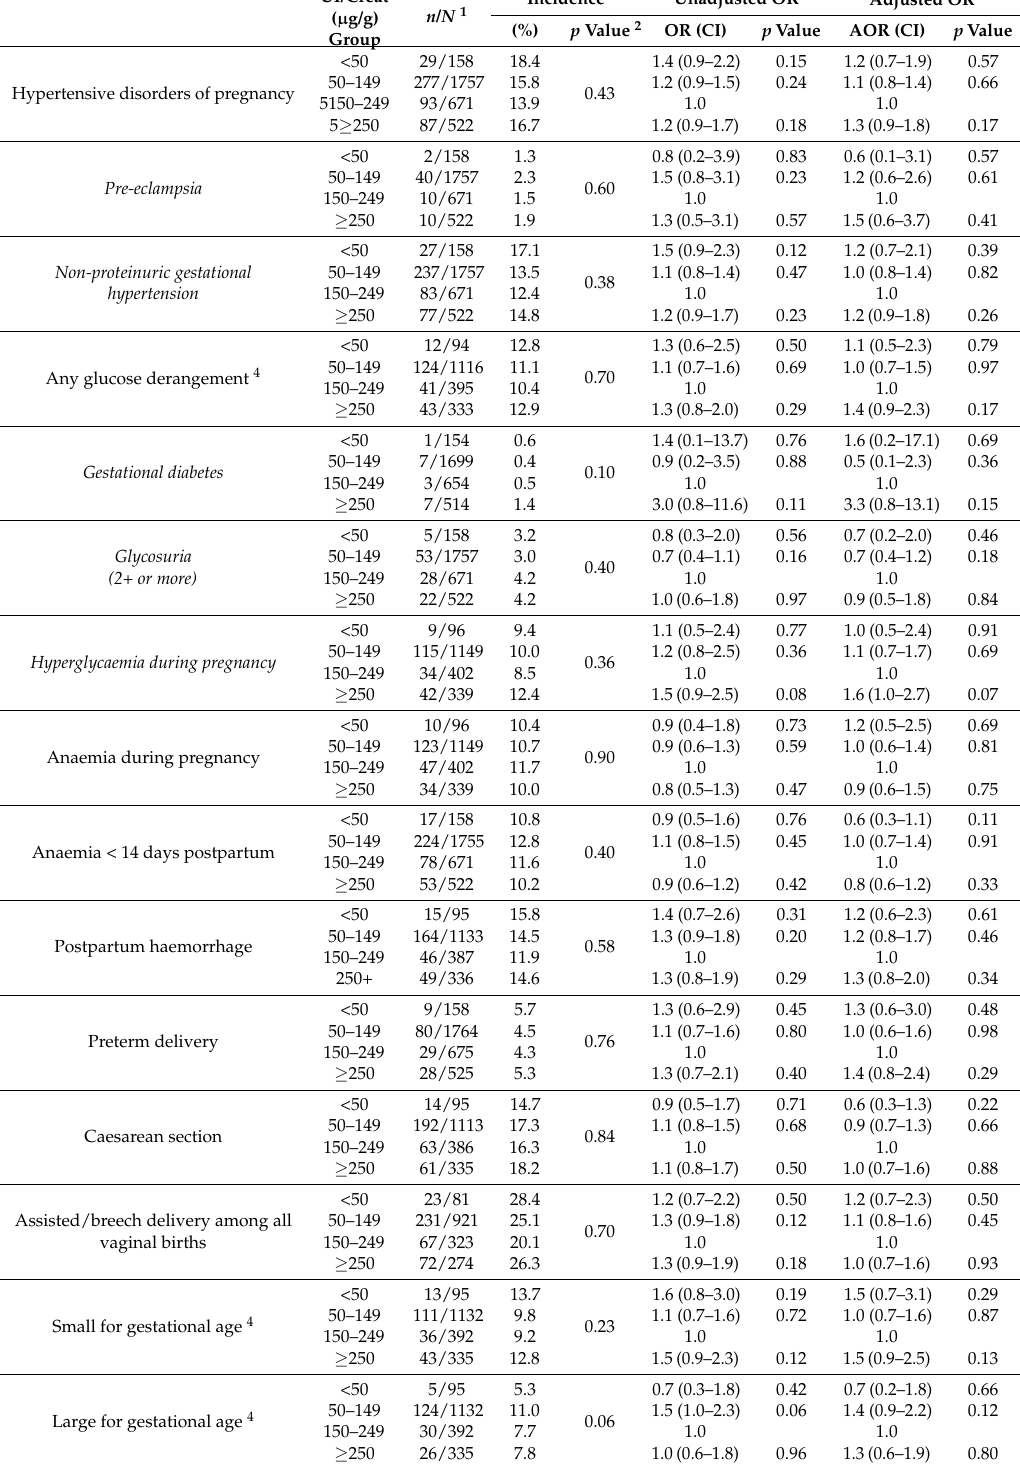
Table 3. Likelihood of each adverse pregnancy outcome in urinary iodine-to-creatinine ratio (UI/Creat) groups; reference group 150–249 µ g/g. Data based on 3140 pregnant women with infants alive at one